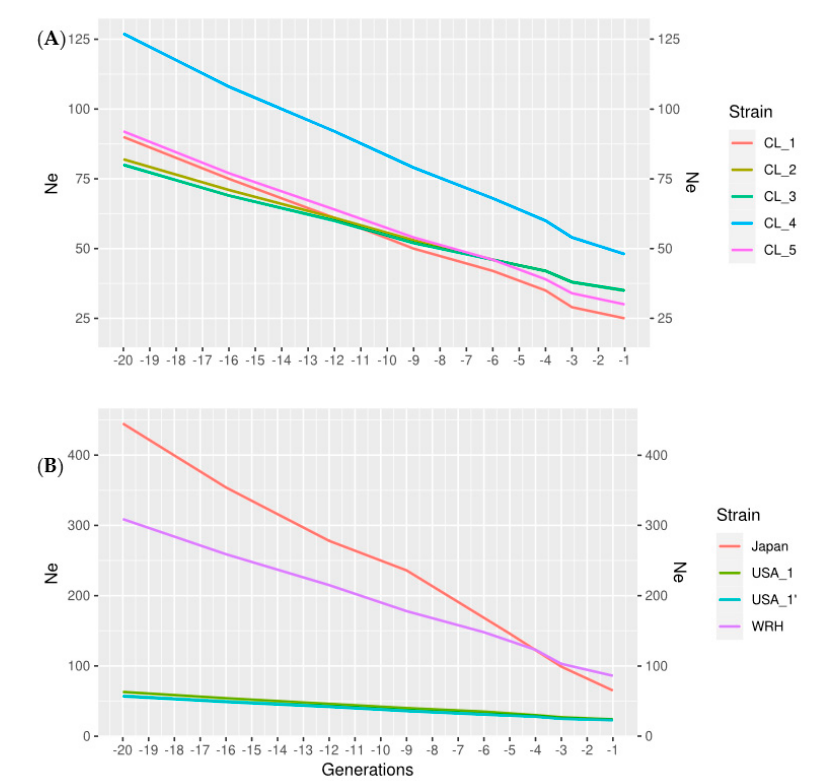
Figure 3. Estimates of Ne within the last twenty generations, obtained using the methods of [27]: ( A ) Chilean strains, and ( B ) North American strains and Japanese strains.